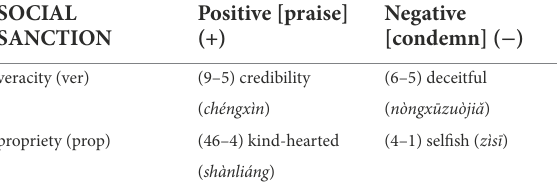
TABLE 3 Categories of judgment of sanction.